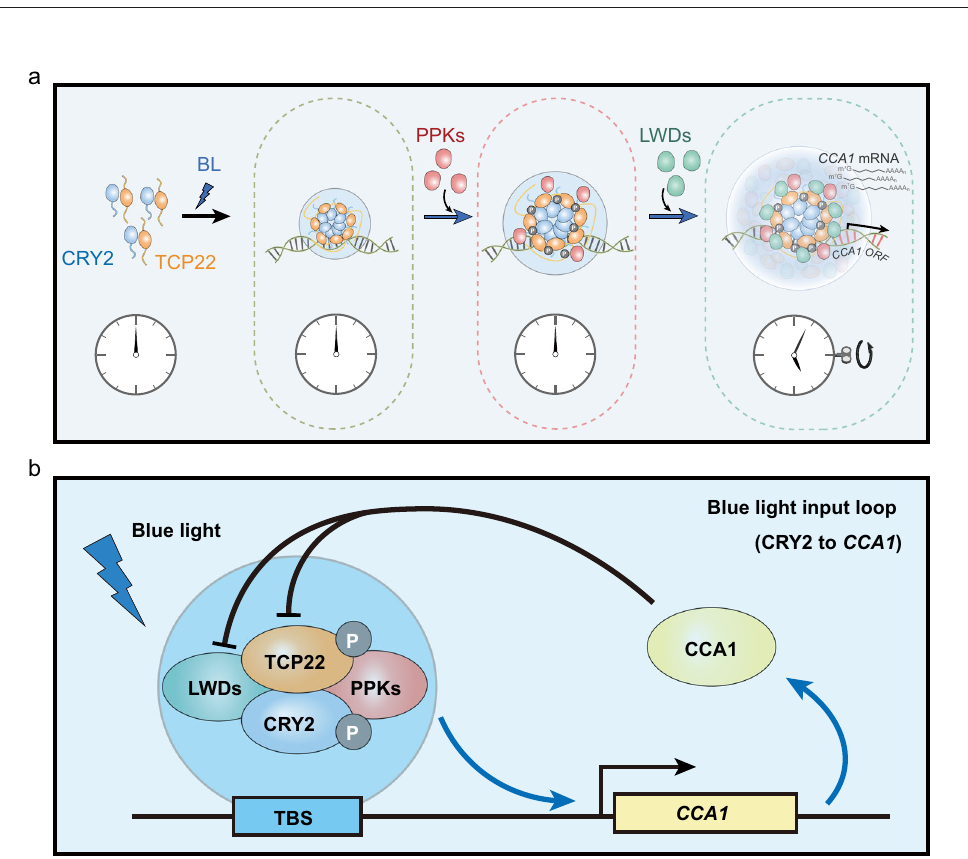
Fig. 5 CRY2, TCP22, LWD1, and PPK1 promote the expression of CCA1 in a reconstituted system. Co-immunoprecipitation assay showing the phosphorylated TCP22 interacted more strongly with LWD1 with Myc-LWD1 immunoprecipitation ( a ) or GFP-TCP22 immunoprecipitation ( b ). Two independent experiments showed similar results. c Co-immunoprecipitation assay showing that CRY2 enhanced the interaction of TCP22-LWD1 under blue light (30 μ mol m − 2 s − 1 ). Two independent experiments showed similar results. d Photobody formation of CRY2-LWDs in Col4 protoplasts. Scale bar, 5 μ m for the CP (Complete protoplast); 3 μ m for the nucleus. Five independent experiments showed similar results. e Photobody formation of indicated plasmids co-expressed in Col4 protoplasts. Five independent experiments showed similar results. Scale bar, 2 μ m. f Size distribution of photobodies in ( e ). ( n = 12 cells for + PPK1 and n = 10 cells for -PPK1). g Partition ratio of ( e ). Data are presented as mean ± SD ( n = 12 cells for + PPK1 and n = 10 cells for -PPK1) ( h ) Photobody formation of the puri fi ed His-TCP22 (8 μ M), His-LWD1 (5 μ M) and His-CRY2 (2 μ M) labeled with iFlour 488, iFlour 405 and CY3, respectively. After mixing with 8 μ M PPK or 8 μ M BSA, photobodies of each sample were observed by confocal microscope. Scale bar, 3 μ m. Five